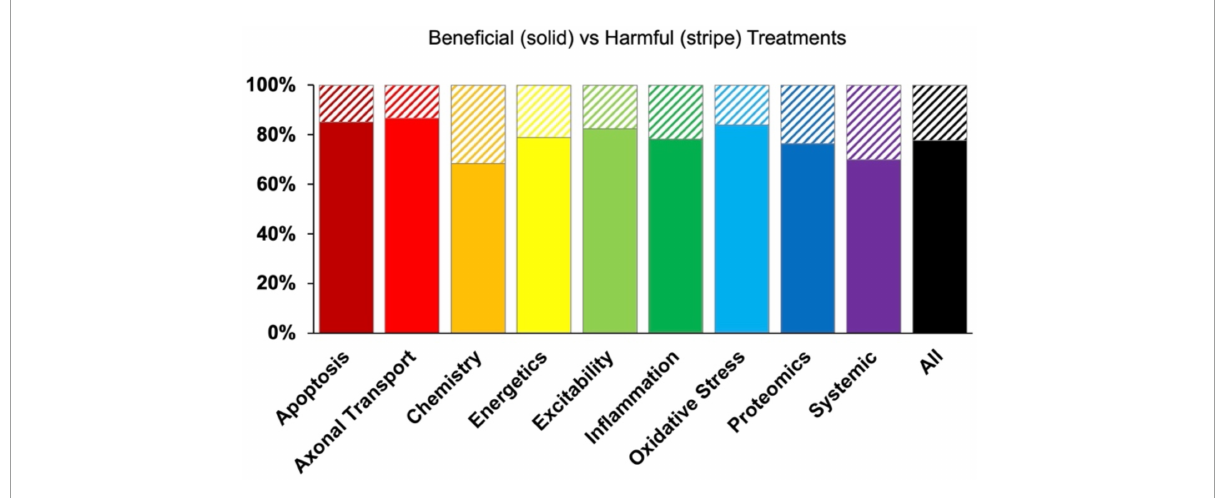
FIGURE6 Percent composition of beneficial (solid bars) versus harmful (striped bars) treatments by pathophysiological treatment category. While some treatment categories reported negative results more frequently than others, there was no significant differences ( p >